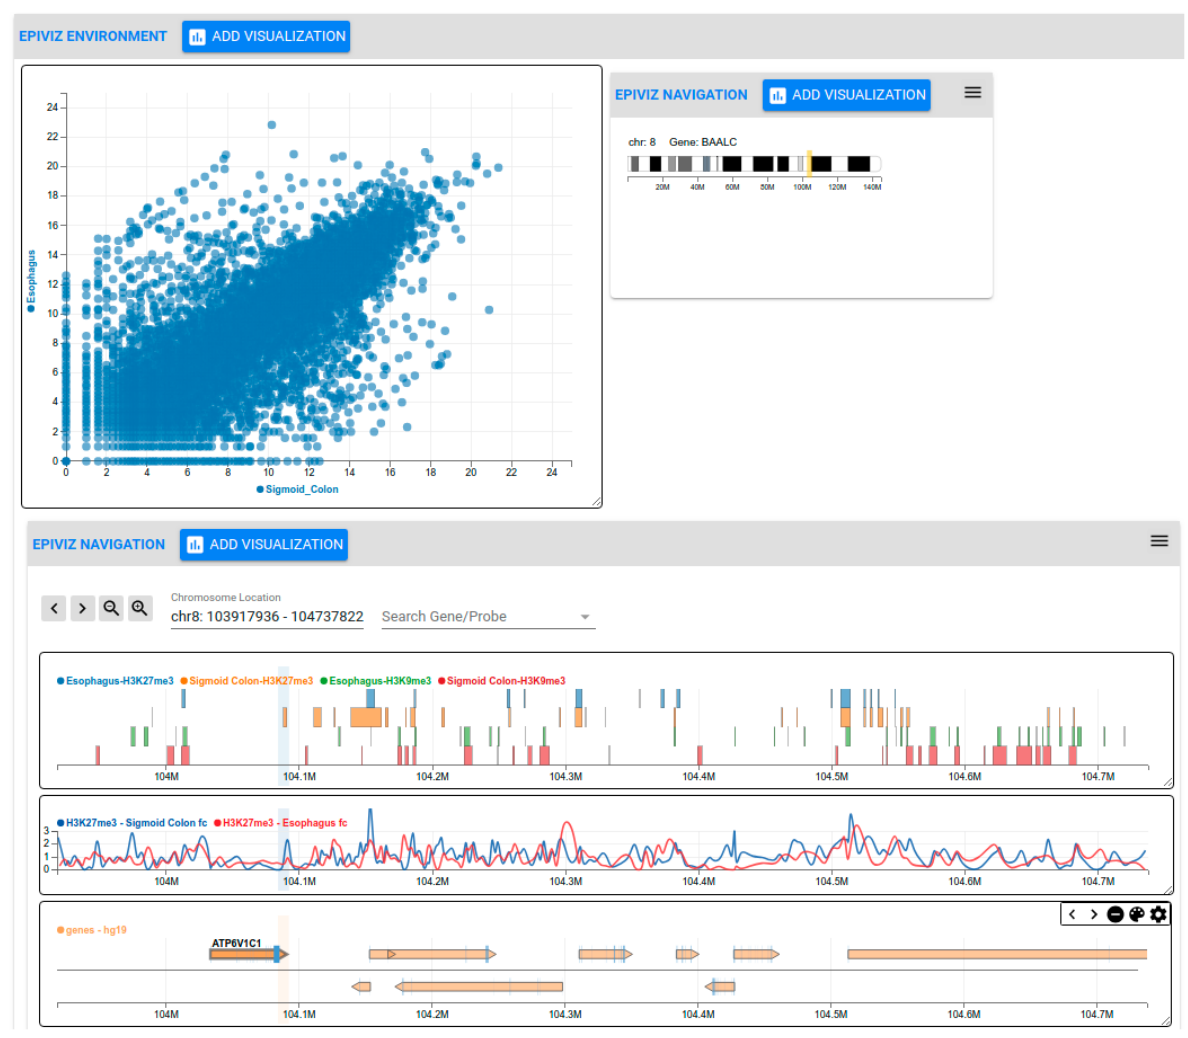
Figure 3. Overview of the Epiviz2 web application for Epigenome Roadmap data. In this workspace, we explore data from the Epigenome Roadmap project in two genomic regions simultaneously ( Epiviz Navigation components) along with a genome-wide scatterplot of gene expression (top left). The environment element is not constrained to a specific genomic region, and hence charts included within them visualize entire datasets. In this example, the scatter plot in the top left shows RNA-seq data for esophagus and colon tissues across the entire genome. EpivizNavigation components, on the other hand, are constrained to specific genomic regions. Given genomic regions or genes of interest in the dataset to further investigate, multiple navigation elements, each corresponding to distinct genomic regions can